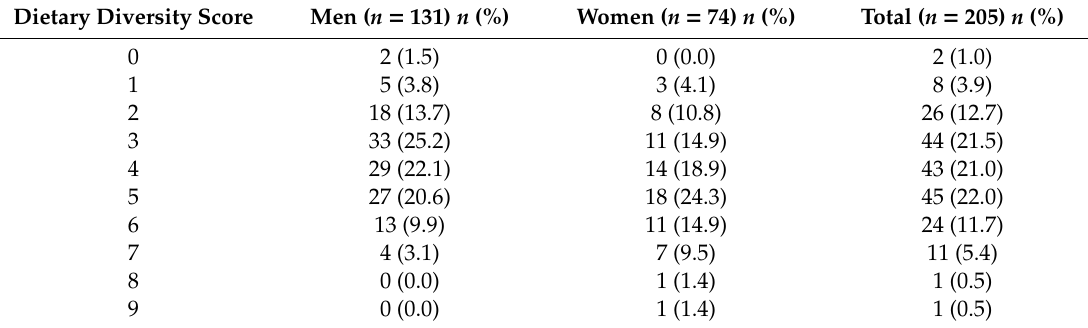
Table 2. Distribution of dietary diversity scores among men and women asylum seekers living in reception centers in southeastern Norway ( n = 205).